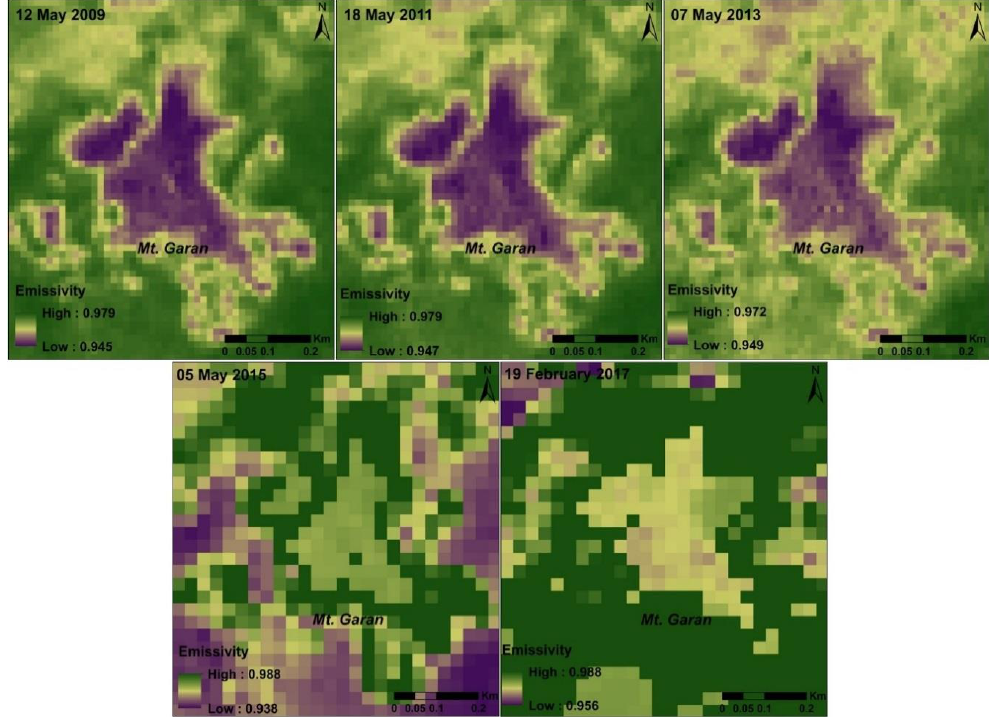
Figure 6. Average emissivity of the land cover of the Garandake fumaroles area from 2009 to 2017.